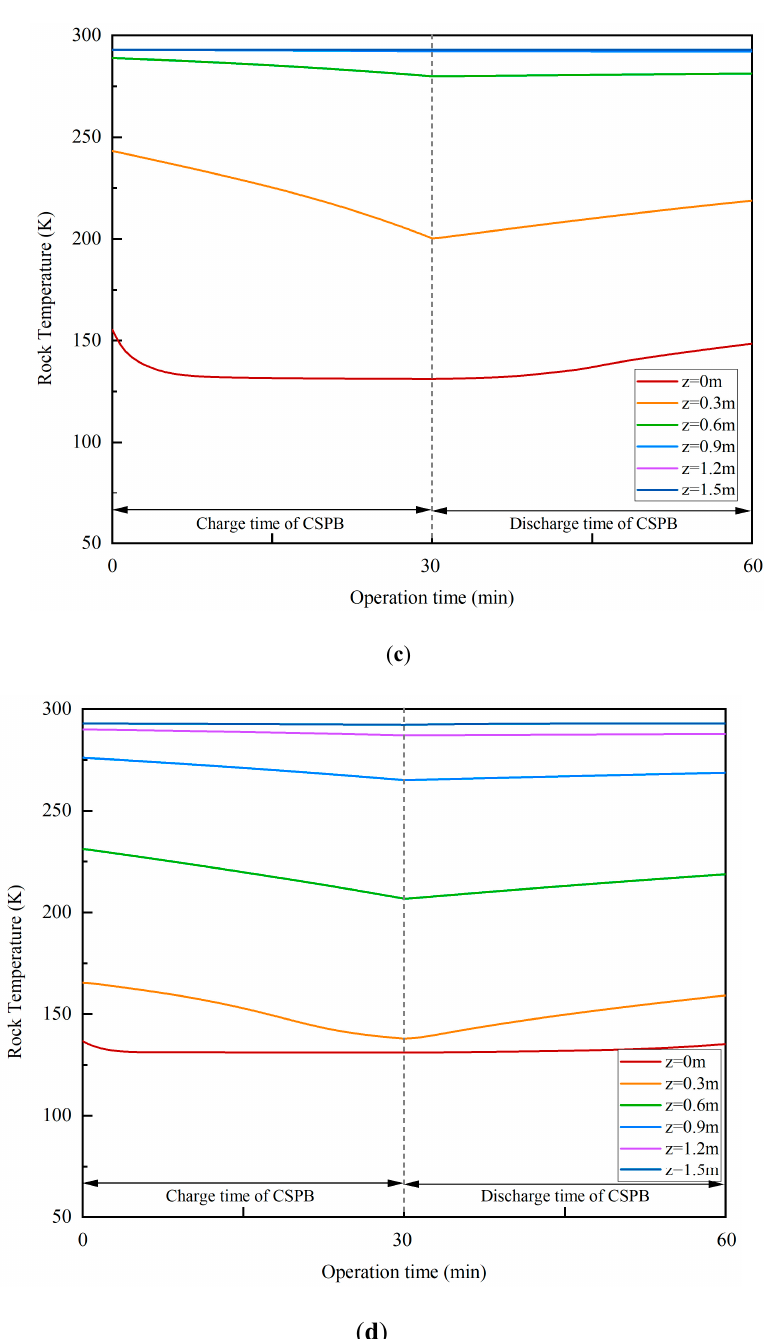
Figure 13. Temperature distributions of rock particles in the CSPB with cycles: ( a ) cycle 1, ( b ) cycle 2, ( c ) cycle 4, ( d ) cycle 9.